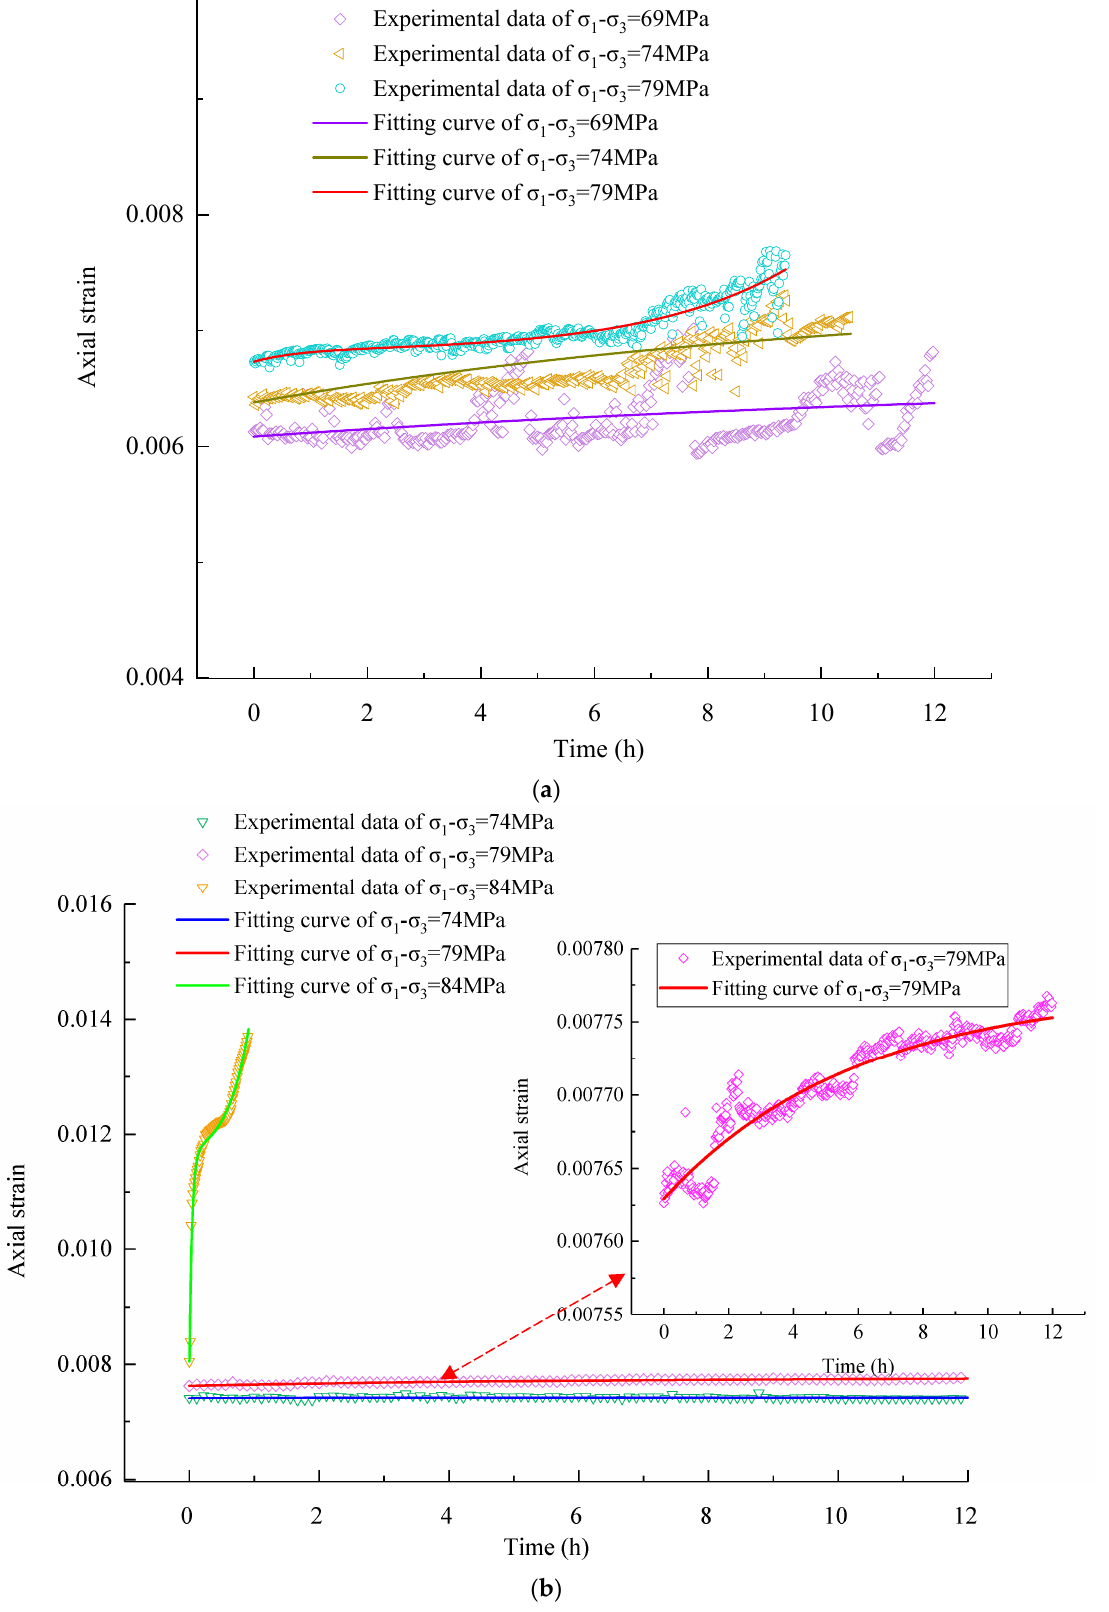
Figure 11. Comparison between the calculation curves and the experimental data under different axial stresses at confining stress of ( a ) 9 MPa and ( b ) 15 MPa.